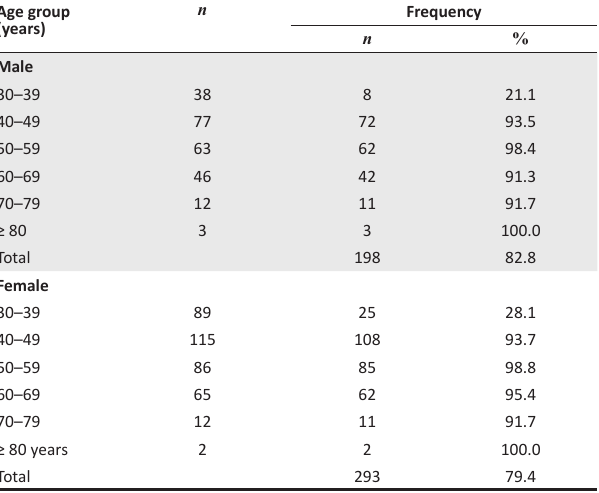
TABLE 1: Prevalence of presbyopia by gender and age group. Age group